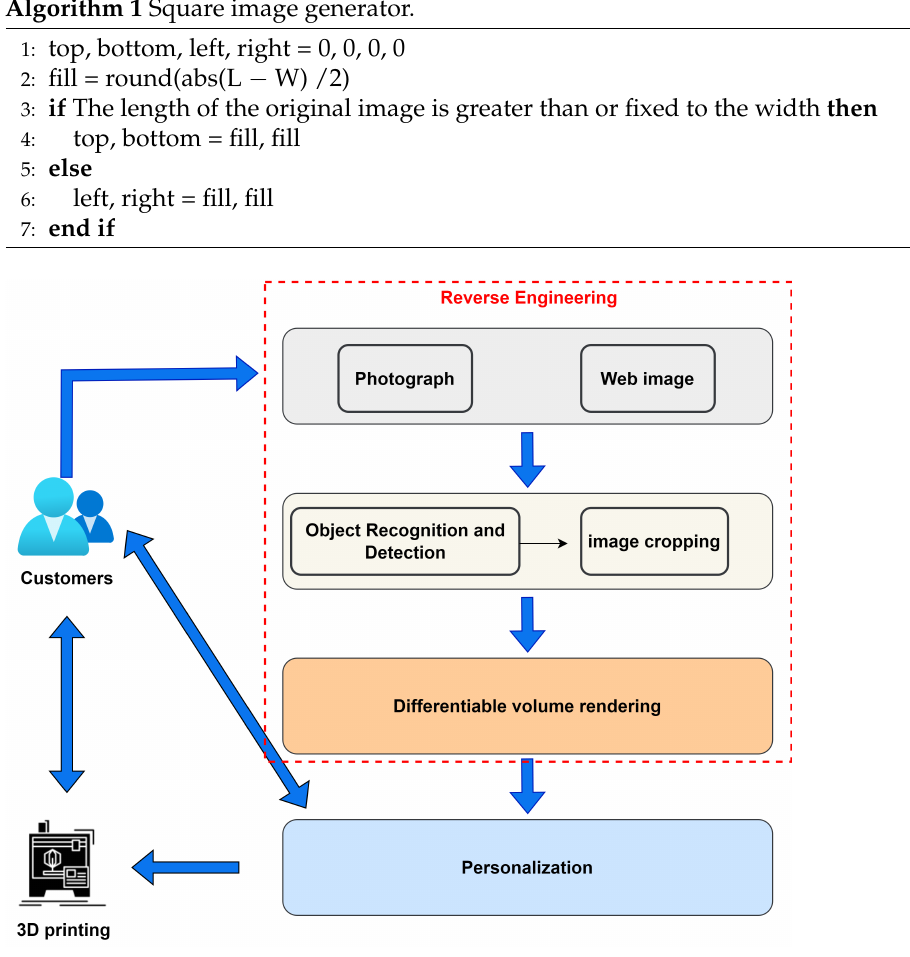
Algorithm 1 Square image generator.